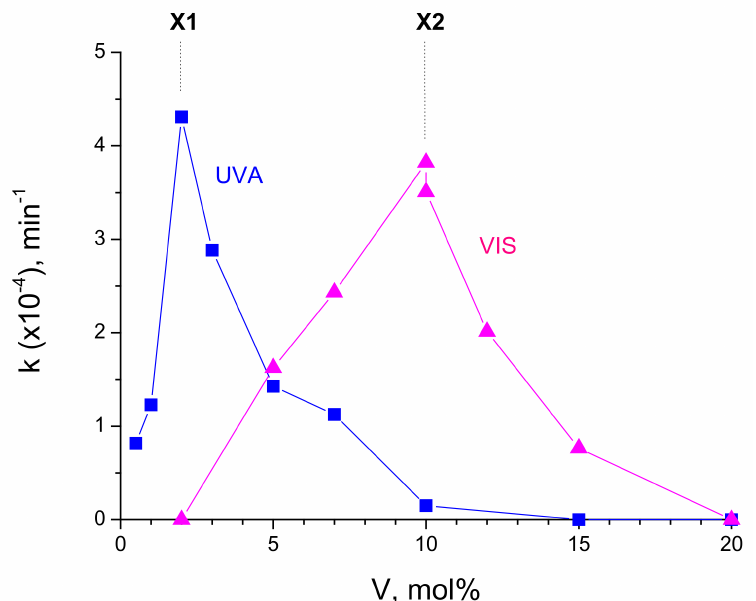
Figure 13. Comparison of V-TiO 2 photocatalysts activities towards MB decomposition under UVA (8 W, λ = 365 nm) and VIS (50 W, λ > 385 nm) lamps illuminations. Participation of active sites X1 and X2 in respective materials can be